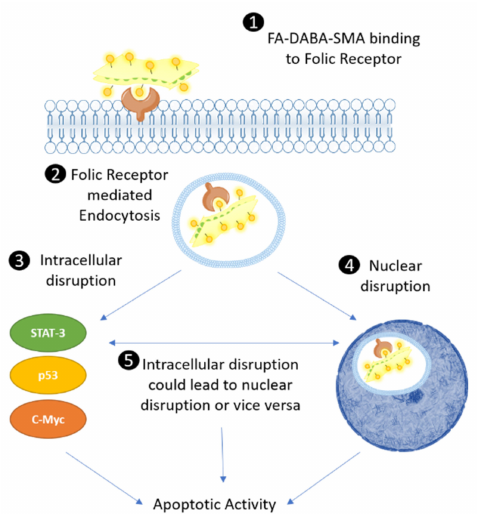
Figure 9. Proposed novel intrinsic therapeutic mechanism of FA-DABA-SMA. (1) FA-DABA-SMA binds to FR α . (2) Through receptor mediated endocytosis, the FR α -FA-SMA-DABA complex is internalized, where it could have two possible intrinsic therapeutic e ff ects. It either (3) remains in the cytoplasm and disrupts the activity of key proliferation proteins such as STAT-3, p53 and c-Myc (and other proteins that maintain cancer growth and proliferation) or (4) the complex is translocated to the nucleus given the role of FR α as a transcription factor. Since FA-DABA-SMA is relatively large (350 kDa), the nanopolymer could theoretically block the binding of additional transcription factors, thus disrupting transcriptional processes of essential oncogenic proliferation proteins, resulting in the reduction of cell viability and activating apoptotic activity. Alternatively, (5) intracellular disruptions of critical cell proliferation proteins could lead to apoptotic events to be activated in the nucleus or, conversely, nuclear disruptions could lead to disruptions in the activity of critical oncogenic proteins. Overall, Steps 3, 4 and 5 could individually or collectively culminate and lead to the activation of apoptotic